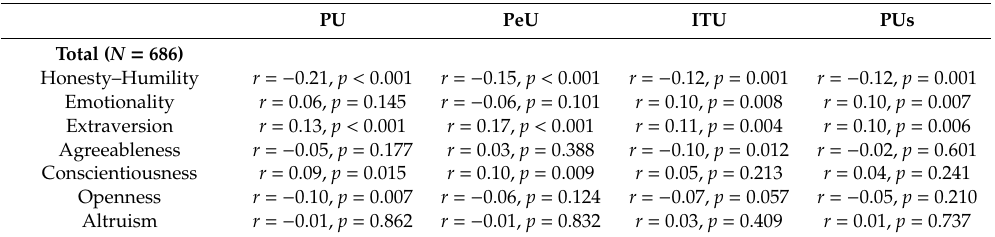
Table A2. Partial Pearson correlations (corrected for age) between the HEXACO-PI-R scales and the scales assessing TA with regard to smartphone use for personal